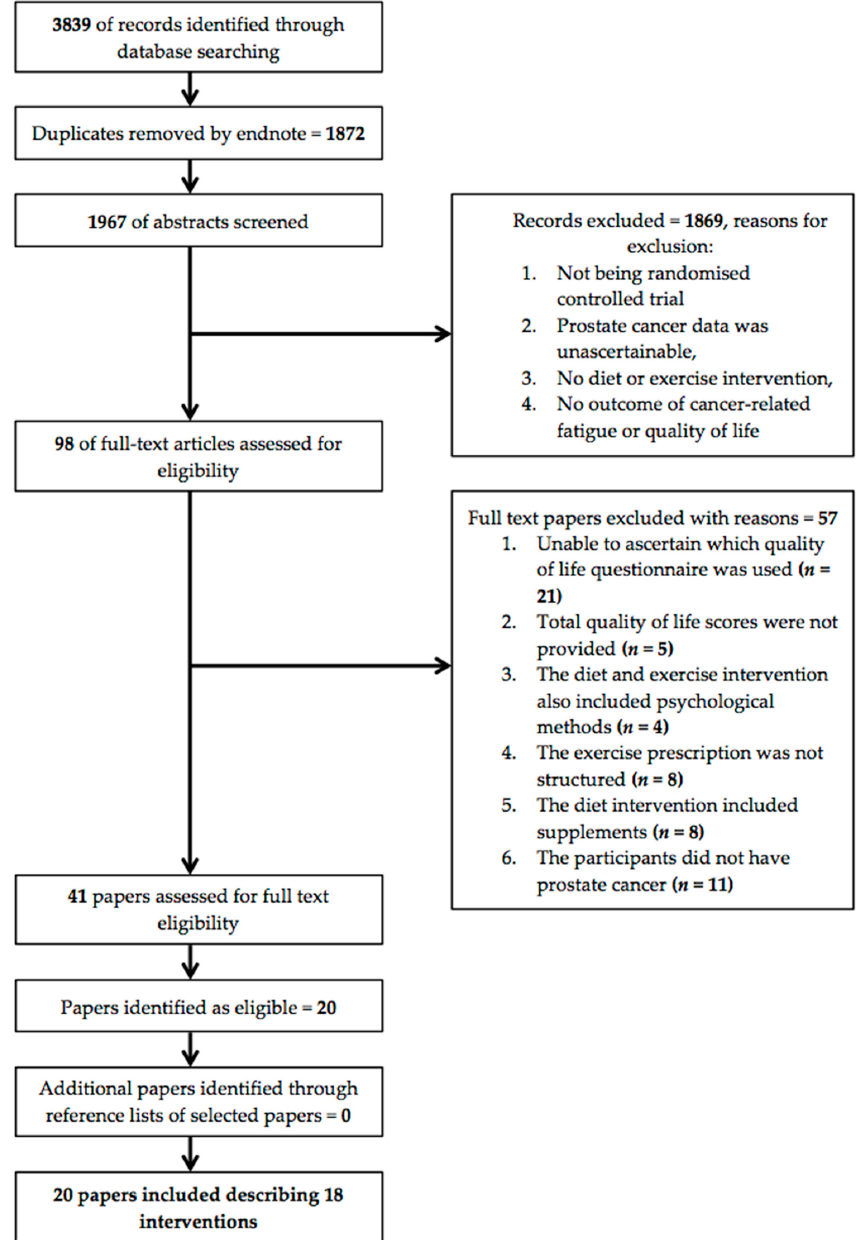
Figure 1. Search process flow chart.